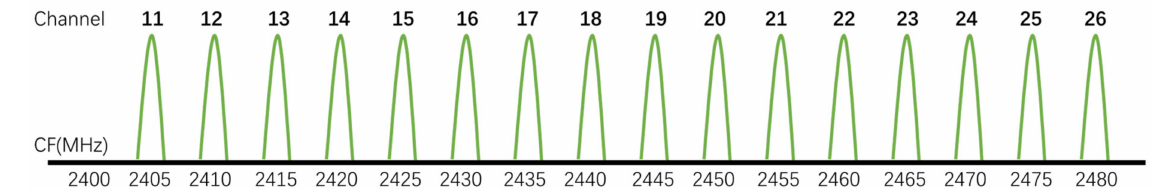
Figure 6. ZigBee channel distribution.